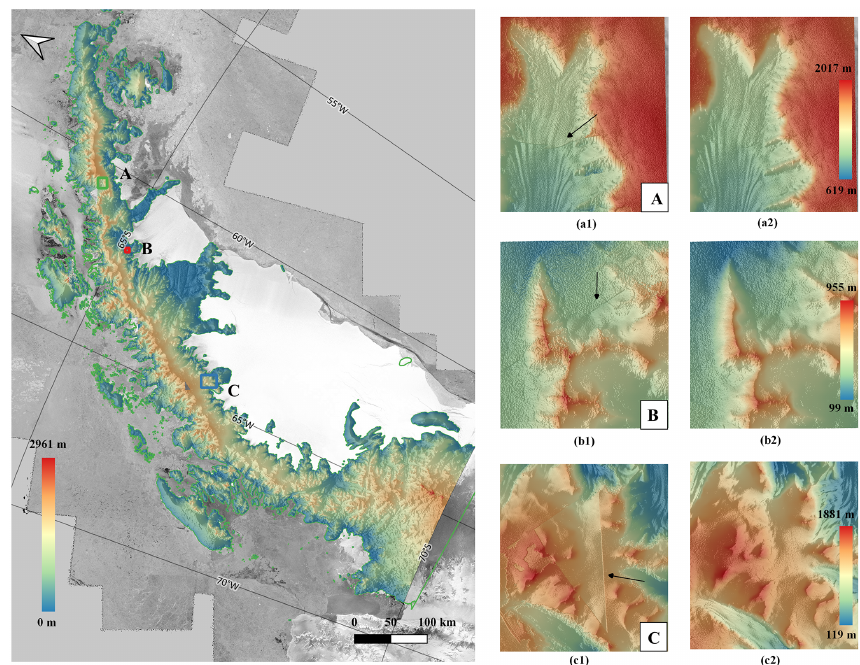
Figure 8. Left: corrected TDM DEM of the Antarctic Peninsula and the location of the sample areas. Right: comparison of the original TDM DEM (a1, b1, c1) with the corrected TDM DEM (a2, b2, c2) in the sample areas A, B and C. Black arrows point to the boundaries of the erroneous areas which have to be